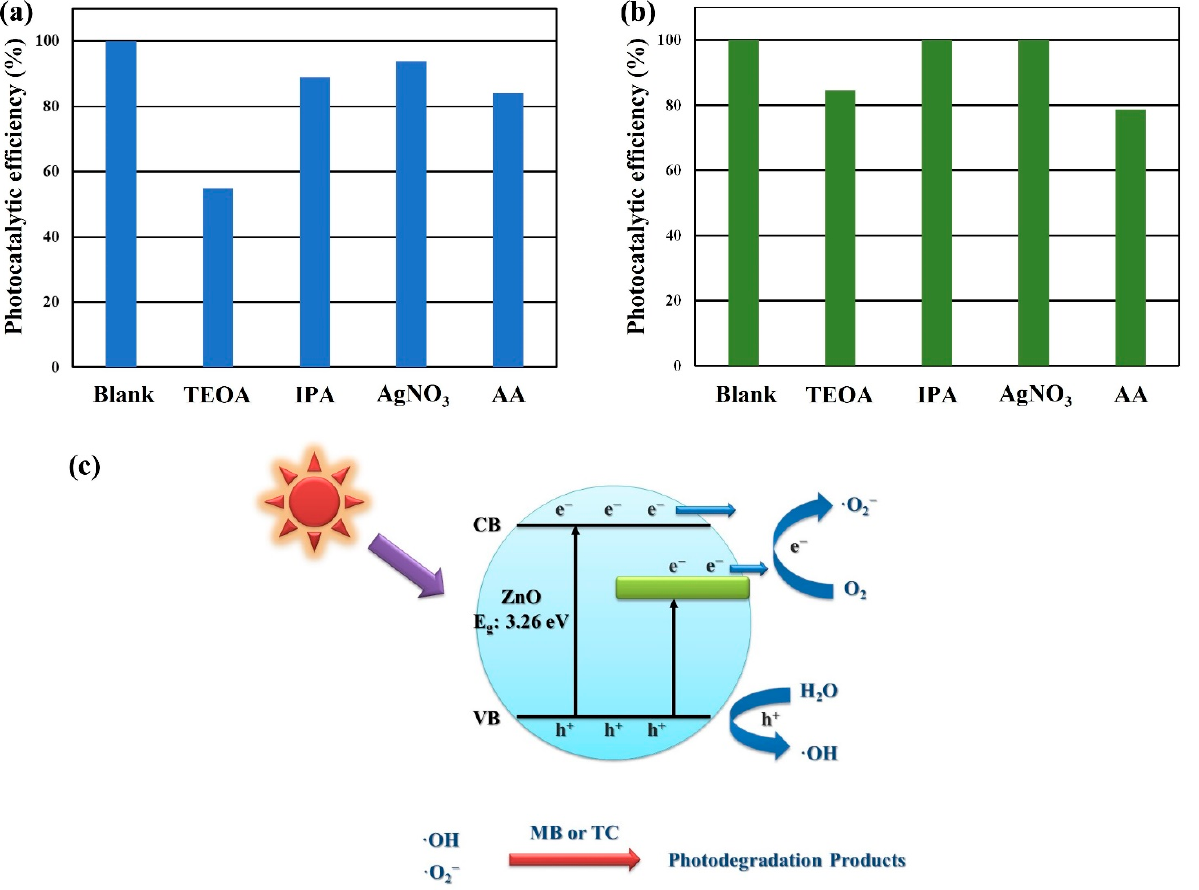
Figure 11. Photocatalytic activities of ZnO nanowalls for ( a ) MB and ( b ) TC solution with various scavengers under UVC light irradiation. ( c ) Schematic diagram of the electron transfer mechanism of ZnO nanowalls under UVC light irradiation.